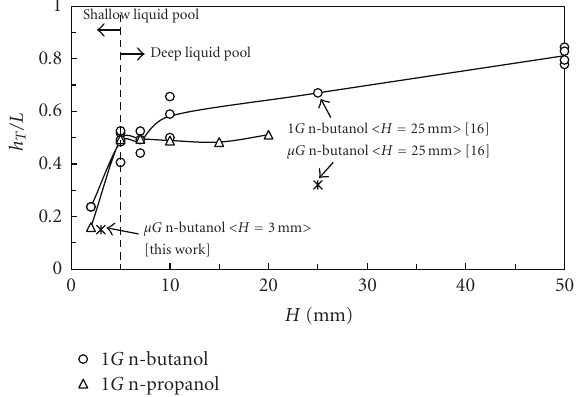
Figure 8: Ratio of characteristic length and characteristic depth of subsurface layer circulation versus initial fuel layer depth (fuel is n- propanol and tray width = 20 mm).